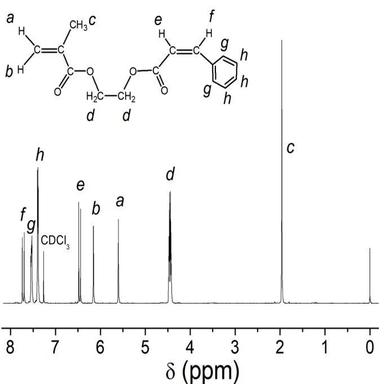
1 H NMR spectrum of monomer methacryloxyvinyl cinnamate (MACA) in CDCl3 solvent.